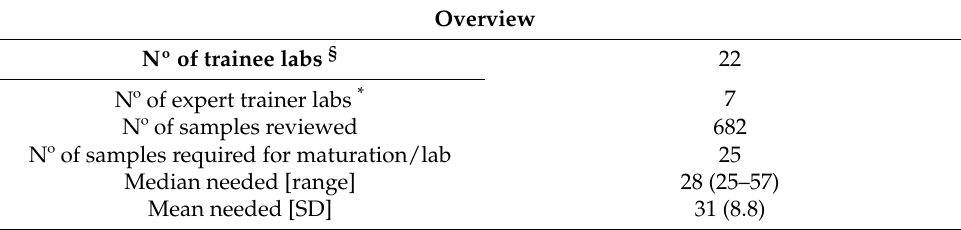
Table 1. Overview of the I-BFM FLOW twinning